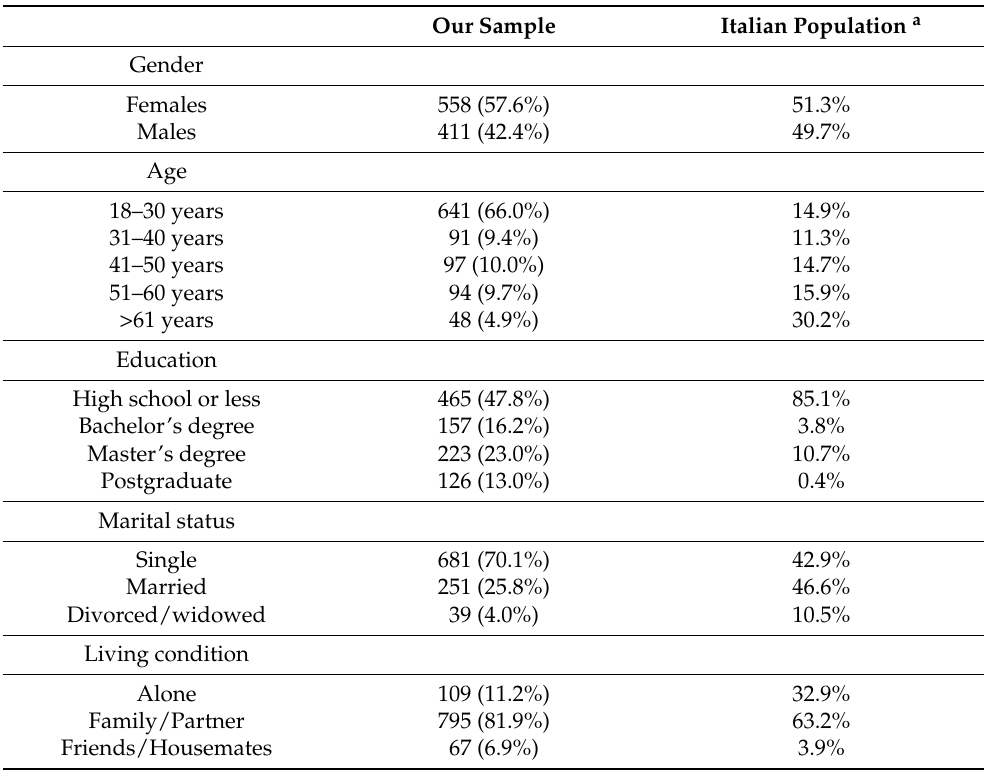
Table 1. Demographic properties of the sample recruited for the present study, as compared to the Italian